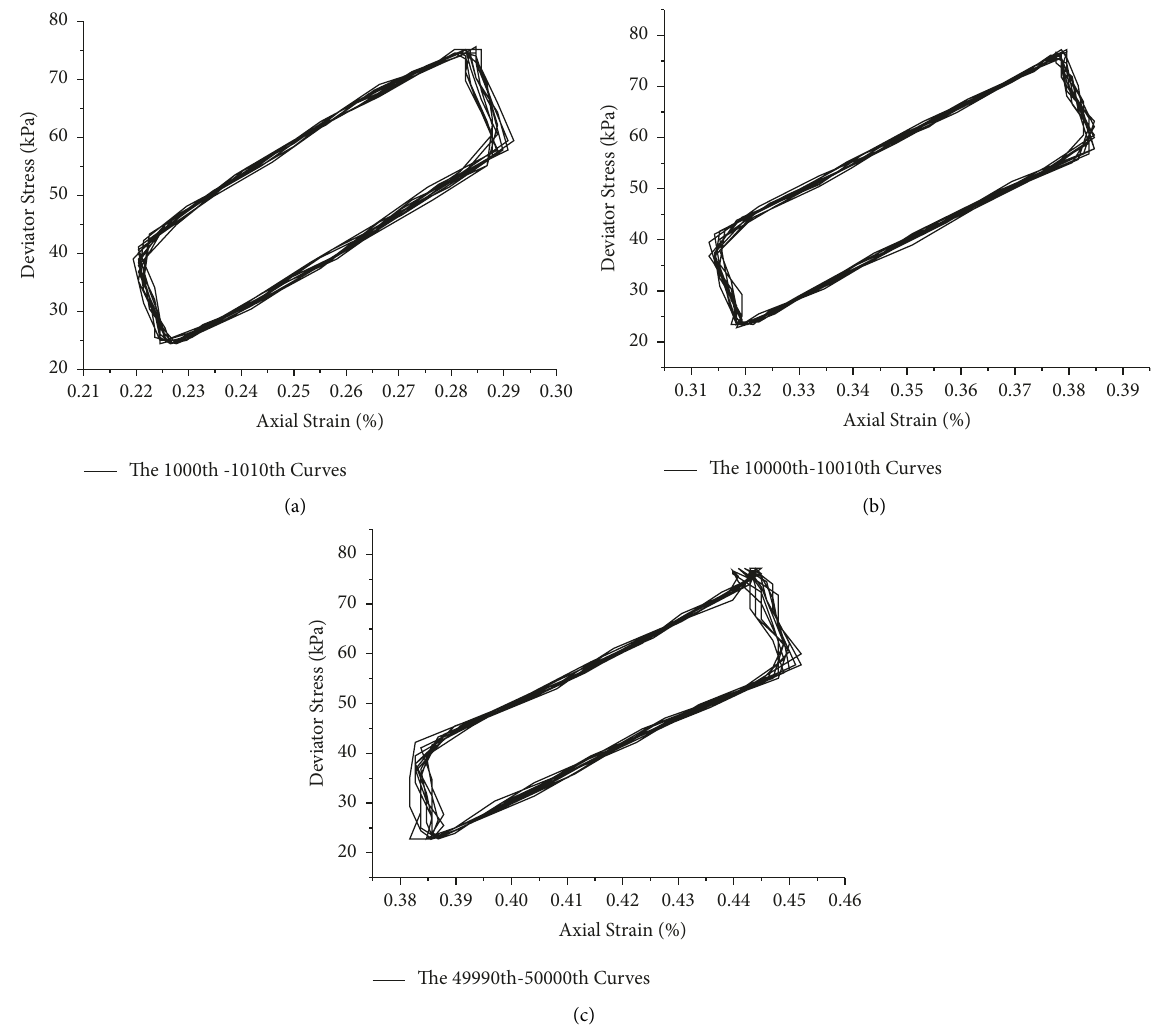
Figure 3: The hysteretic curves while σ 49990 th –50000 th curves.